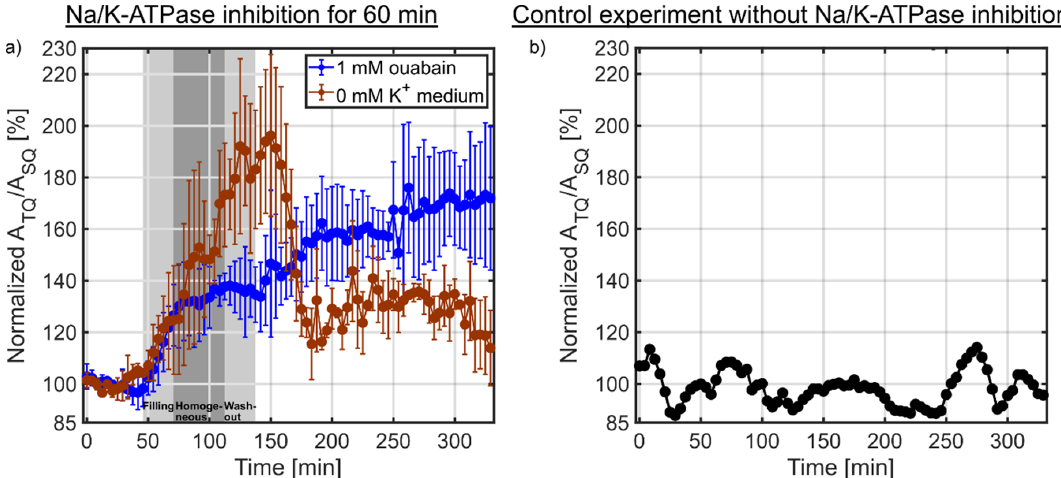
Figure 6. ( a ) Dynamic measurements of the sodium TQ signal during the Na/K-ATPase inhibition for 60 min using 1 mM ouabain (n = 3) or 0 mM K + medium (n = 3). The two light gray shaded backgrounds indicate the filling and washout of the bolus in the bioreactor, while the dark gray shaded background corresponds to the homogeneous distribution of the bolus in the bioreactor determined using the 1 H MR contrast agent experiment (Figure 2). In both experiments, a similar initial increase in the sodium TQ signal was observed. The sodium TQ signal reached an intermediate plateau of 138.9 ± 4.1% ( p < 0.01) for the ouabain experiment from 75–142 min, while in the 0 mM K + medium experiment a plateau of 183.4 ± 8.9% ( p < 0.01) was reached from 120-160 min. During reperfusion by normal medium, the sodium TQ signal further increased to 169.2 ± 5.3% ( p < 0.01) for the ouabain experiment which indicated a loss of cell viability and further influx of sodium ions. In the experiment using 0 mM K + medium, the sodium TQ signal decreased to 128.5 ± 6.8% ( p < 0.01) during reperfusion, which indicated a partial restoration of Na/K-ATPase pump activity and partial cell viability. ( b ) Temporal stability of the sodium TQ signal in the presence of a 3D cell culture without Na/K-ATPase inhibition. The sodium TQ signal fluctuated only around the mean value.